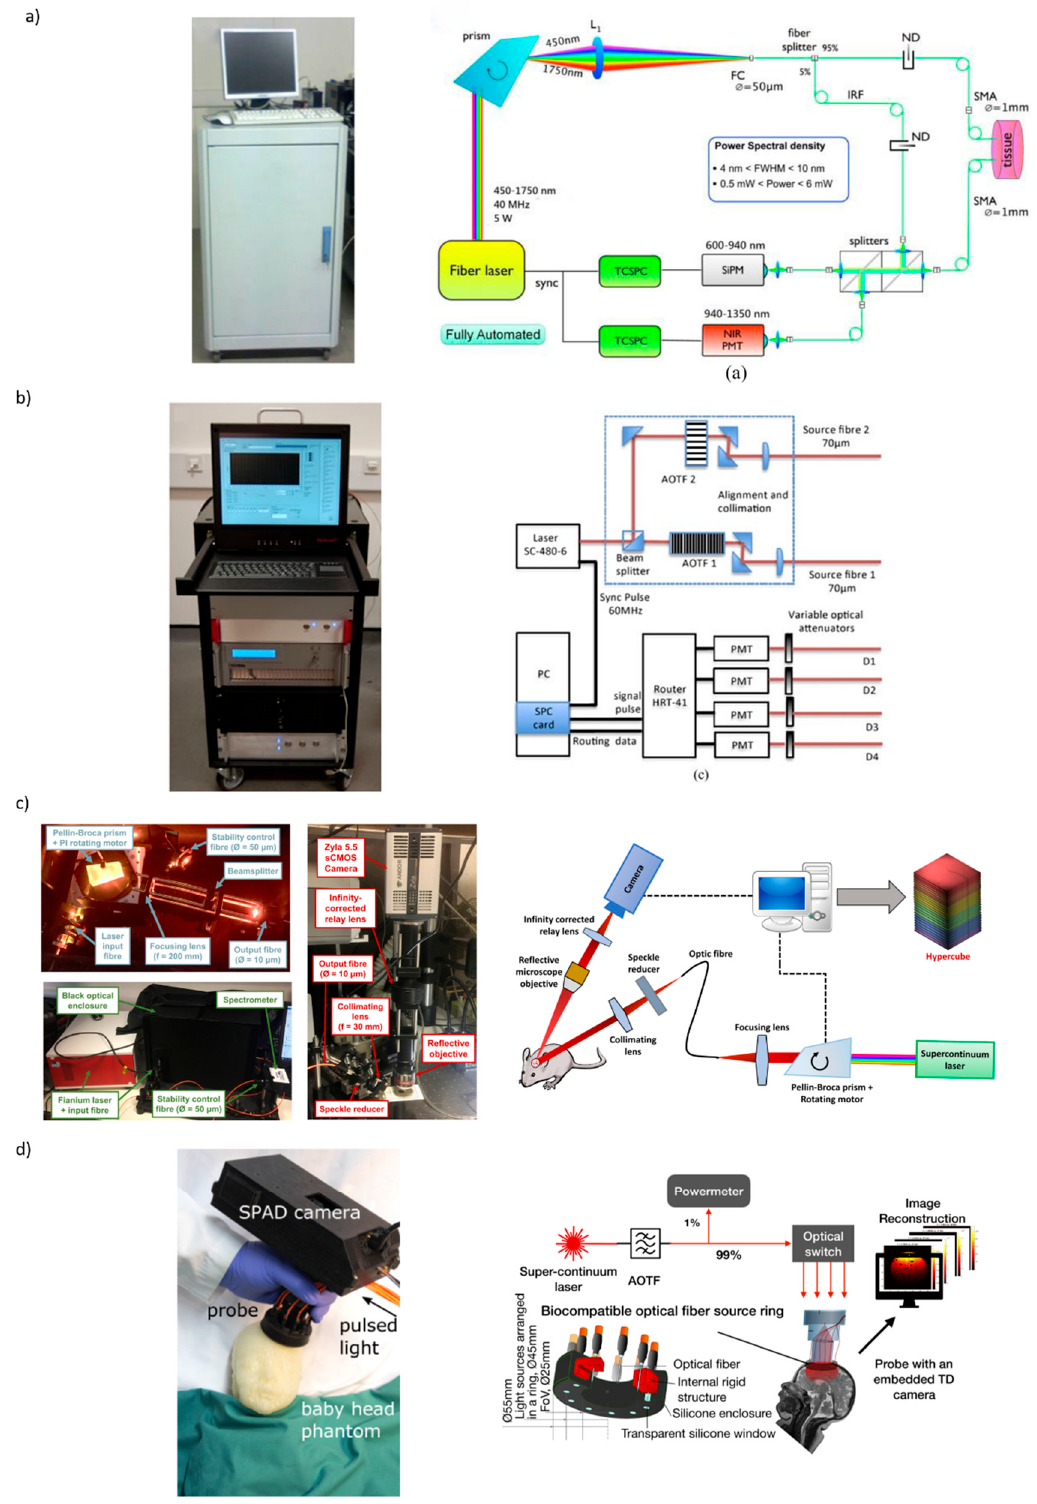
Figure 2. Pictures and schematic of various instruments based on SCL as a source. ( a ) TD-NIRS instrument aimed at broadband characterization of tissues. Figure reproduced from [23]. ( b ) TD-NIRS instrument aimed at monitoring both oxygenation and metabolism functional changes. Figure reproduced from [24]. ( c ) Preclinical instrument aimed at monitoring the exposed brain cortex of rodents. (reproduced with permission from [25], Copyright IEEE, 2021). ( d ) DOT system based on a SPAD camera aimed at functional brain monitoring in neonates. Figure reproduced from [26,27].